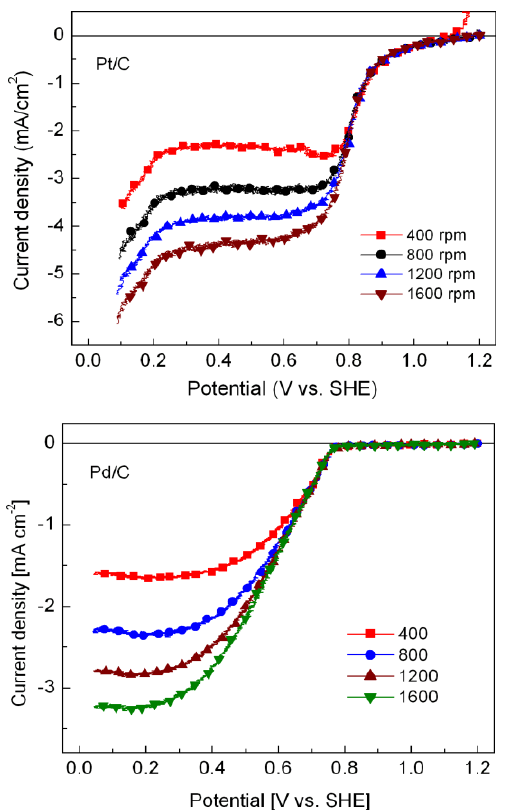
Figure 3. Polarization curves of the ORR at Pt/C and Pd/C. Electrolyte: 0.5 M H Temperature: 25 °C. Scan rate: 5